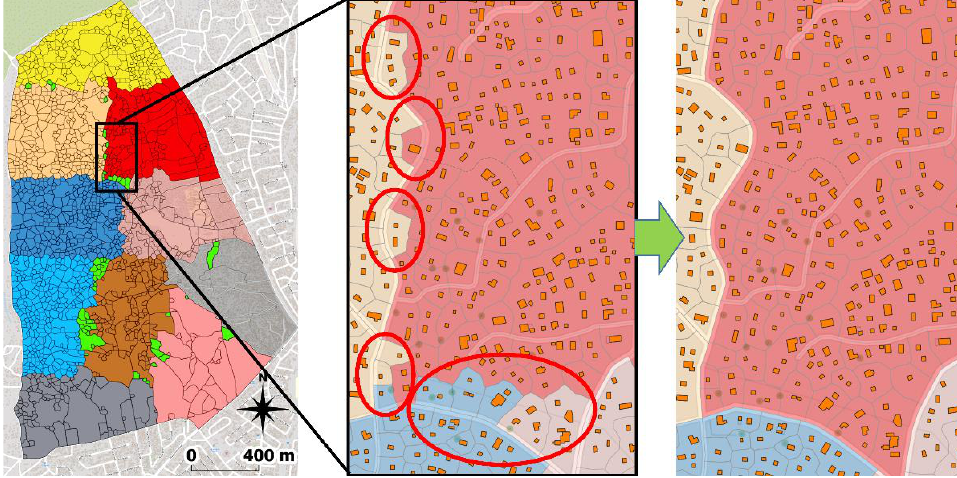
Figure 7. Manual adjustments after automated zoning (basemap/buildings/polygons: [47]).